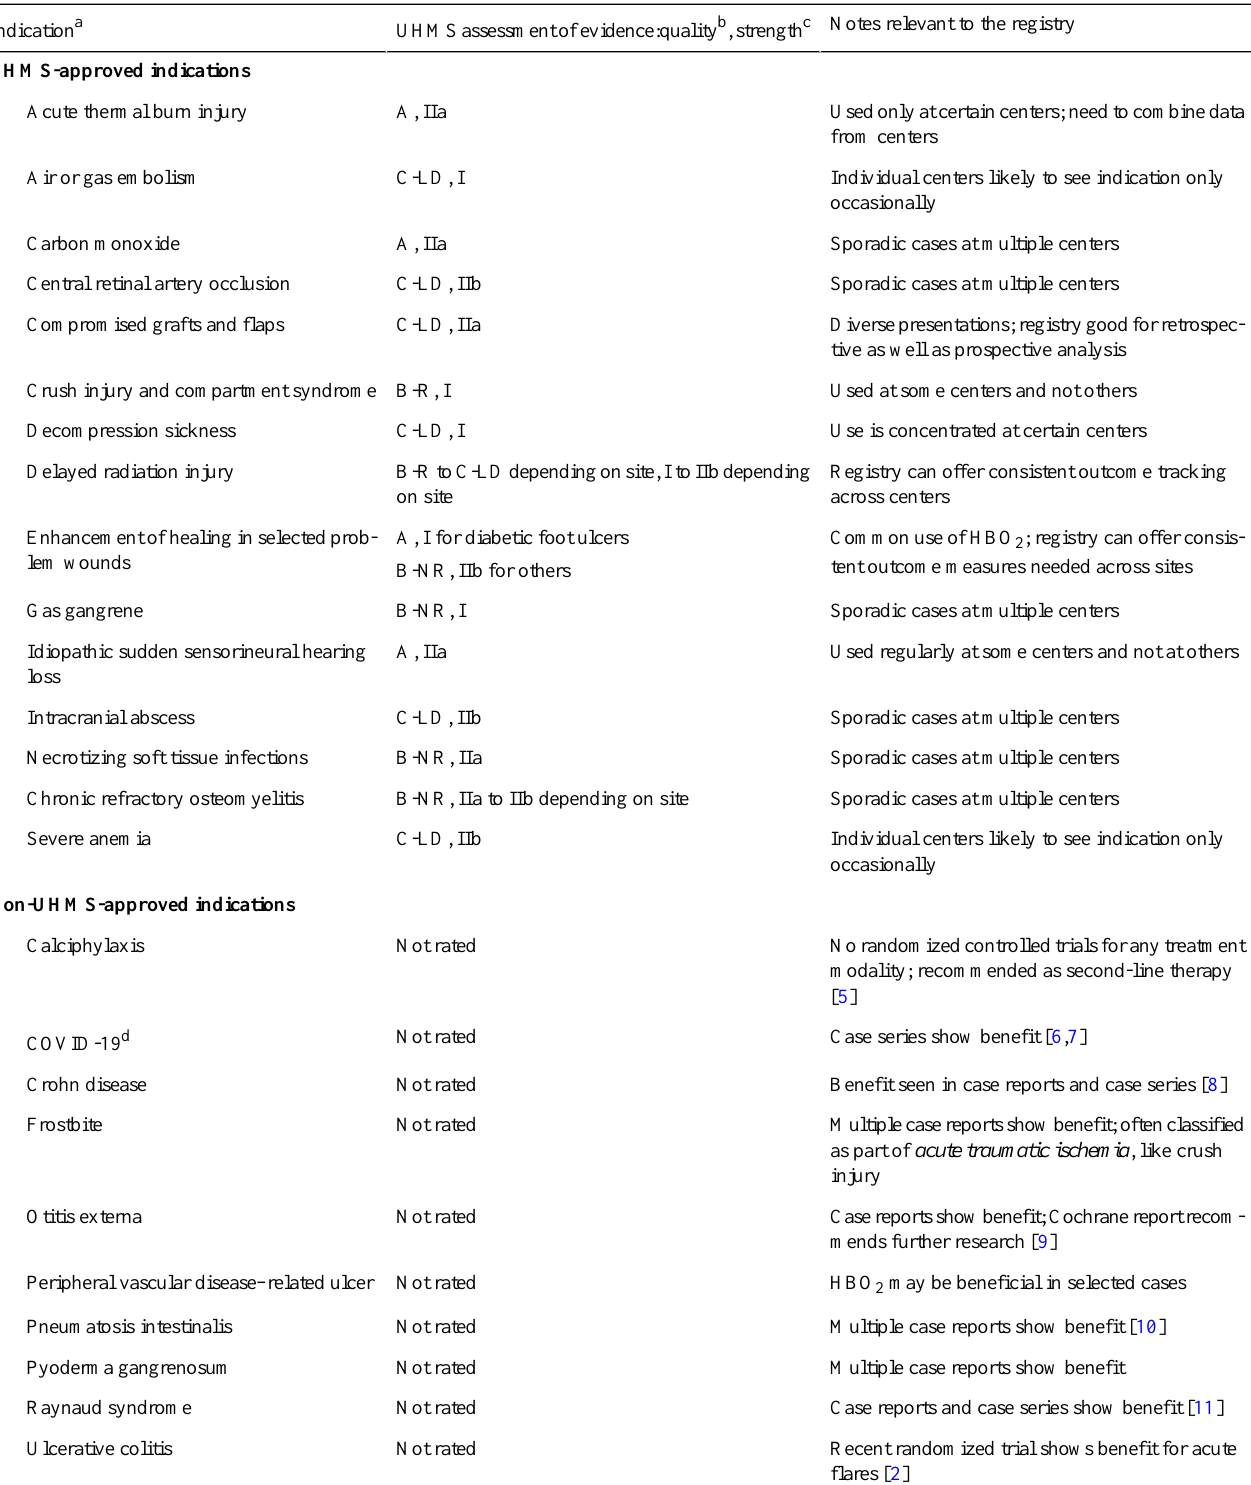
Table 1. Indications for hyperbaric oxygen (HBO 2 ) therapy with Undersea and Hyperbaric Medical Society (UHMS) assessment of the quality and strength of evidence from the UHMS Indications report